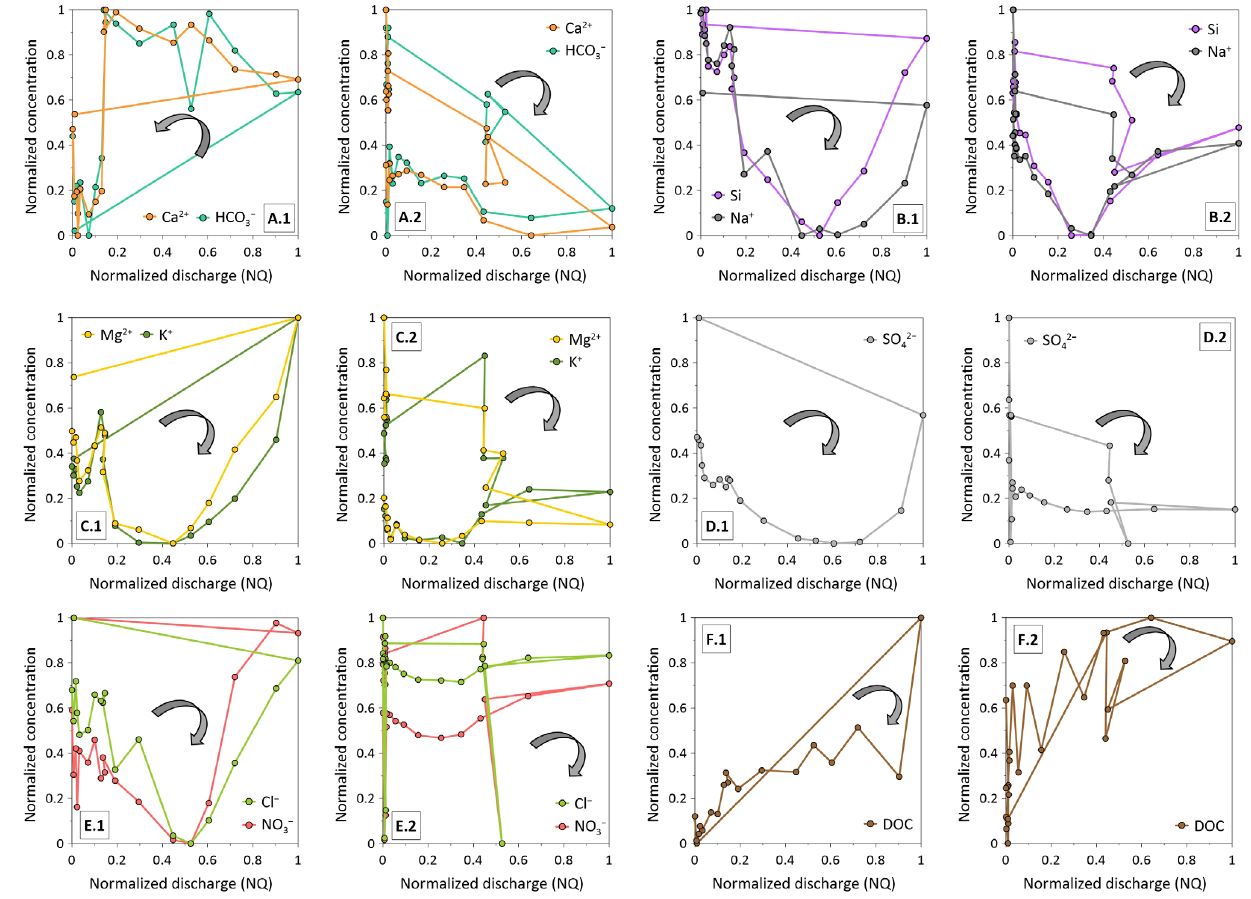
Figure 5. C-Q relationships showing the hysteresis loops the for major elements: ( A ) for Ca 2+ and HCO 3 − , ( B ) Si and Na + , ( C ) Mg 2+ and K + , ( D ) SO 42 − , ( E ) Cl − and NO 3 − and, ( F ) DOC, during the flood events 2 (number 1) and 11 (number 2). For example, A.1 and A.2 refer to Ca and HCO 3- during flood events 2 and 11, respectively. The data are normalized (see Equations (3) and (4)).